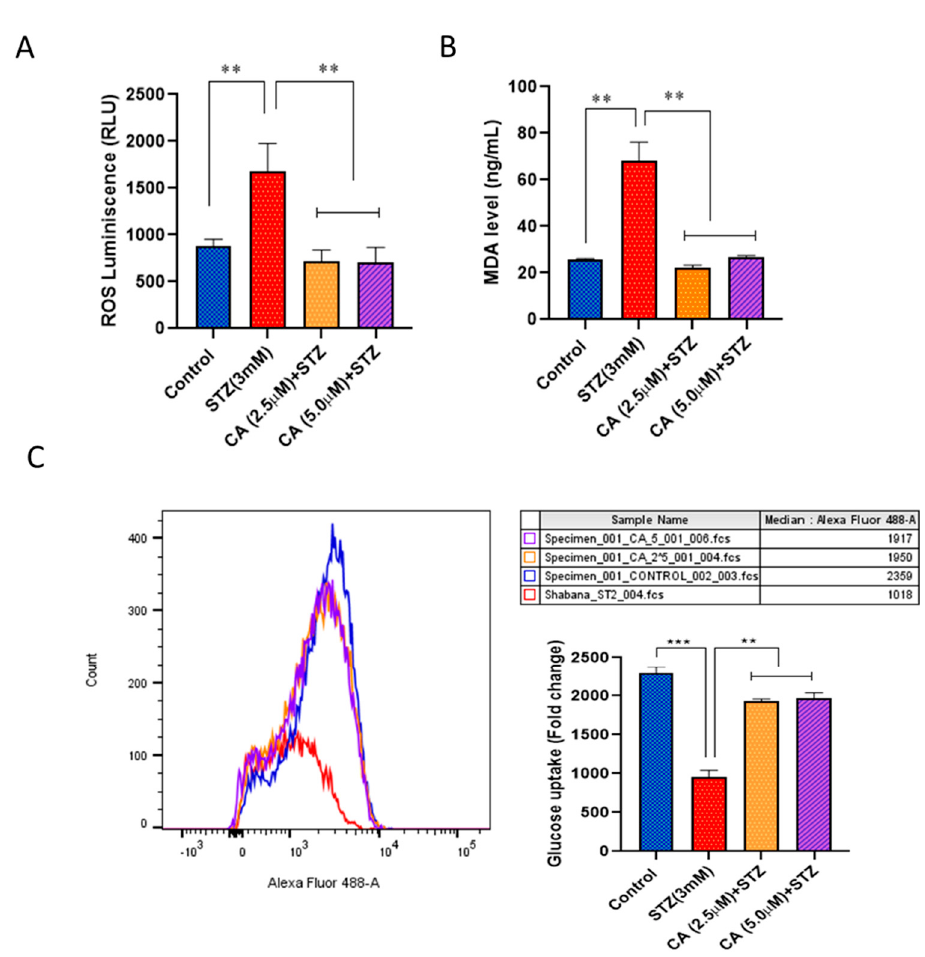
Figure 3. Impact of CA on ( A ) ROS production, ( B ) MDA levels, and ( C ) glucose uptake in STZ-treated cells. Levels of ROS and MDA were determined by fluorescence intensity, while glucose uptake assessment was measured by flow cytometry. Data presented are obtained from three independent experiments. ** p < 0.01, *** p < 0.001. Bars represent mean ± SD.